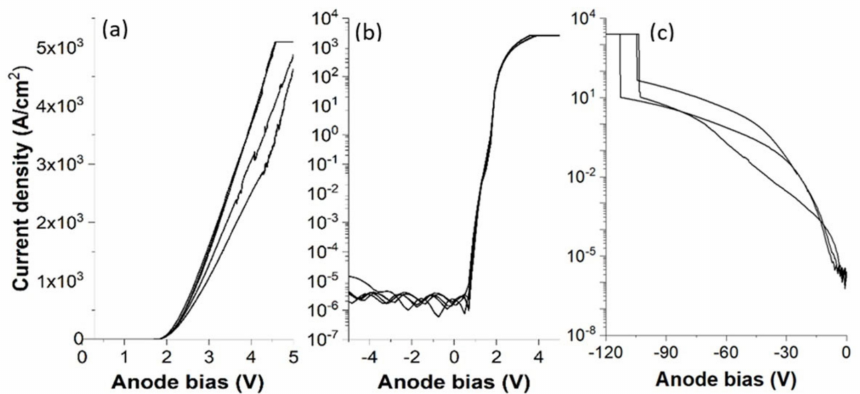
Figure 11. ( a ) Forward J-V characteristics, ( b ) on-off performance at ± 5 V, and ( c ) reverse breakdown of bulk 3C-SiC PiN